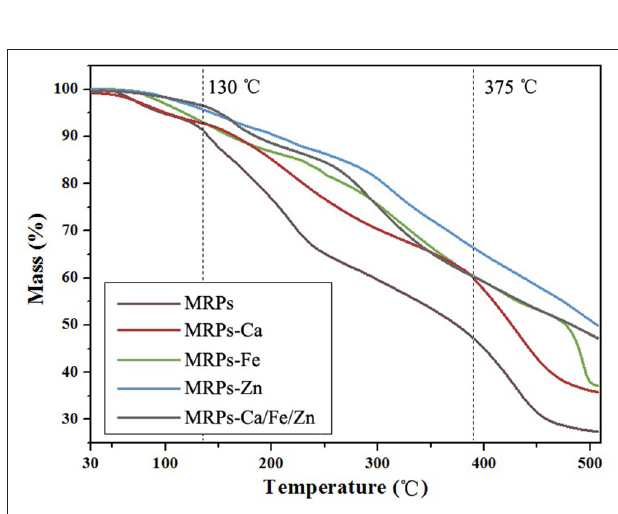
MRPs–Ca/Fe/Zn underwent an insignificant loss process instead of severe ones. Overall, the complexes are competent in the normal environment of agricultural